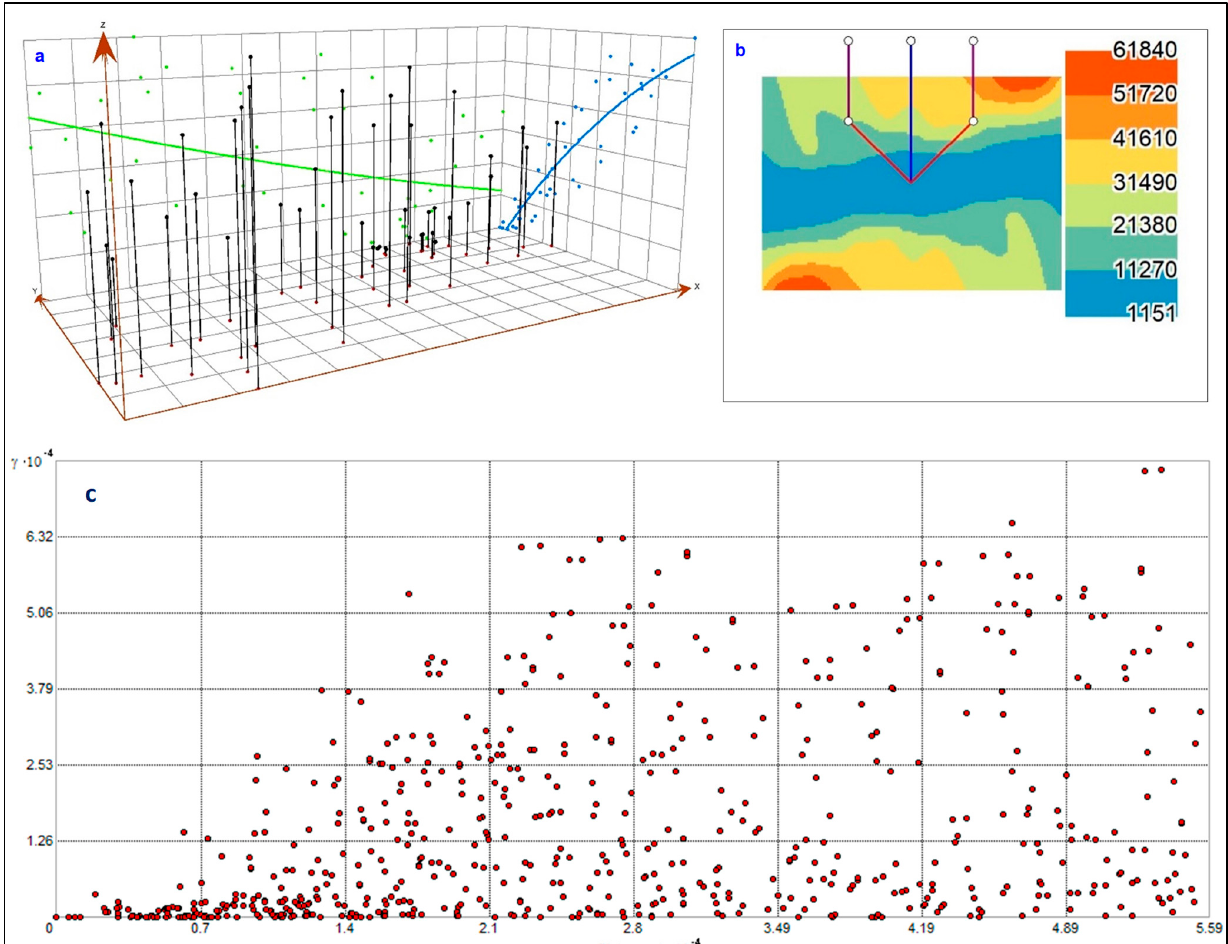
Figure 6. Control of data quality. ( a ) Trend tool. ( b ) Variographic surface: an anisotropic behavior with variability in the 45° direction. ( c ) Semivariographic cloud: calculated values of the variance γ (h) for all pairs of the samples plotted on the Y axis against the distance h separating the two locations, represented on the X axis .